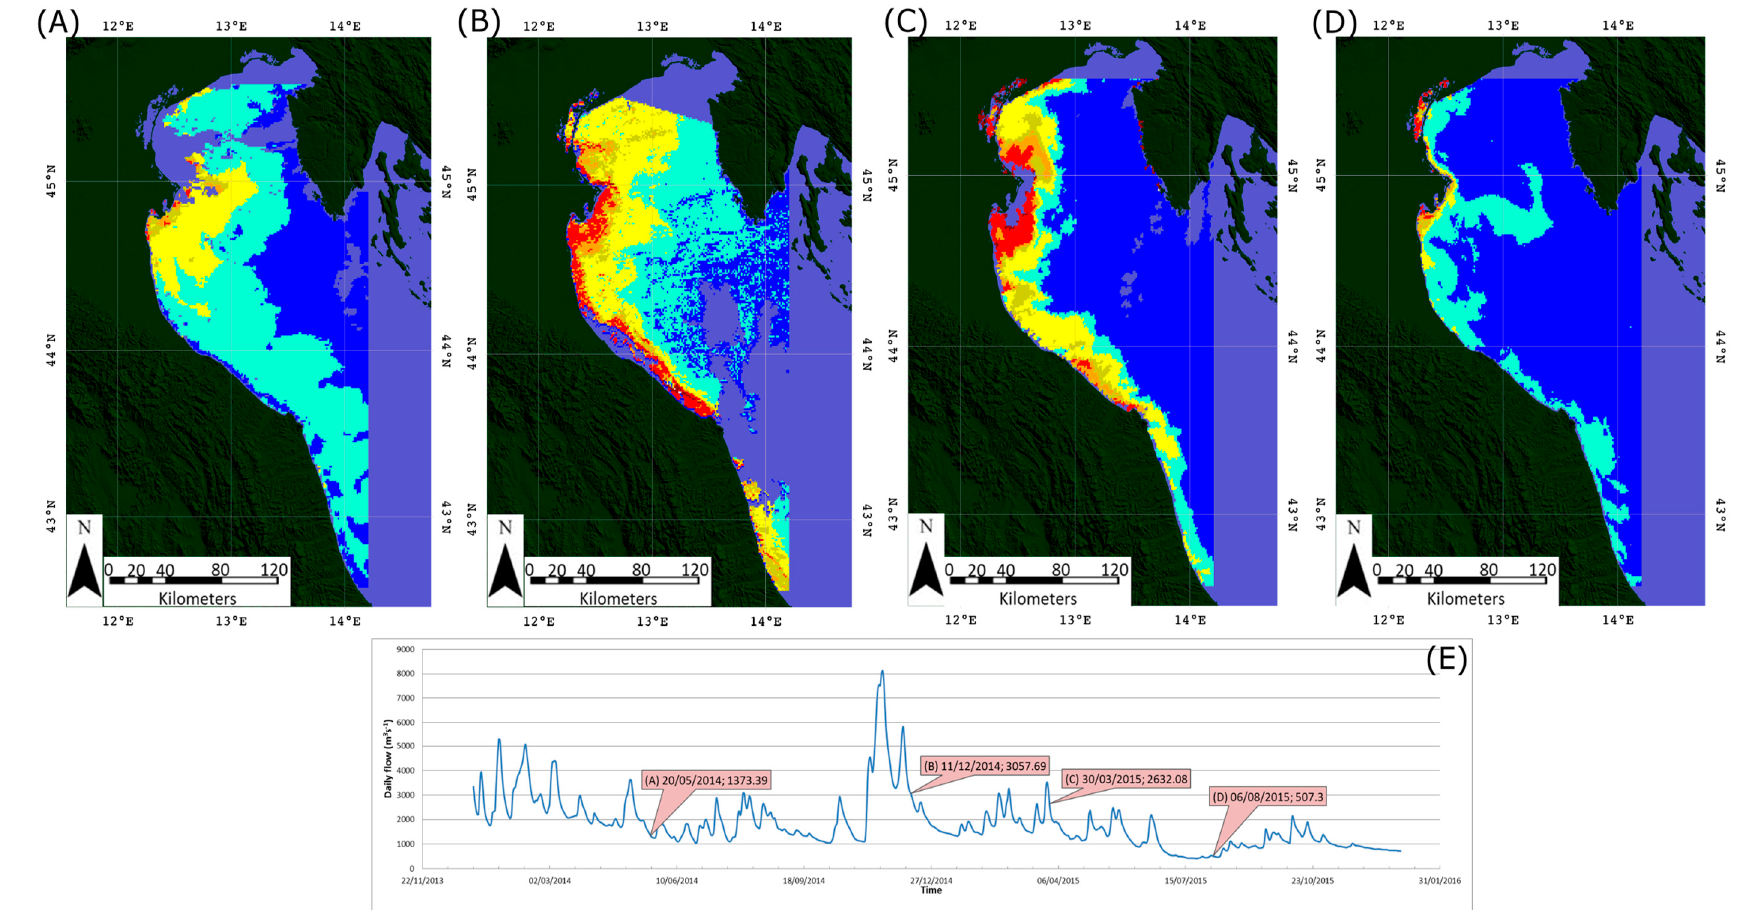
Figure 9. Satellite-derived a CDOM 355 maps obtained using MODIS-A R rs computed using the Model 2 equation (a CDOM 355 0.5 = b 1 + b 2 × R rs (667)/ R rs (488)) for the days: ( A ) 20 May 2014; ( B ) 11 December 2014; ( C ) 30 March 2015; and ( D ) 6 August 2015. The calculated maps matches pretty well the flow rates of the Po River ( E ). CDOM maps are overlaid (only for visualization purposes) on ASTER GDEM World Wide Elevation data (1 arc-second of spatial resolution) where dark green colour depicts land and the blue-violet colour the sea (in our case, no-data values due to the clouds).